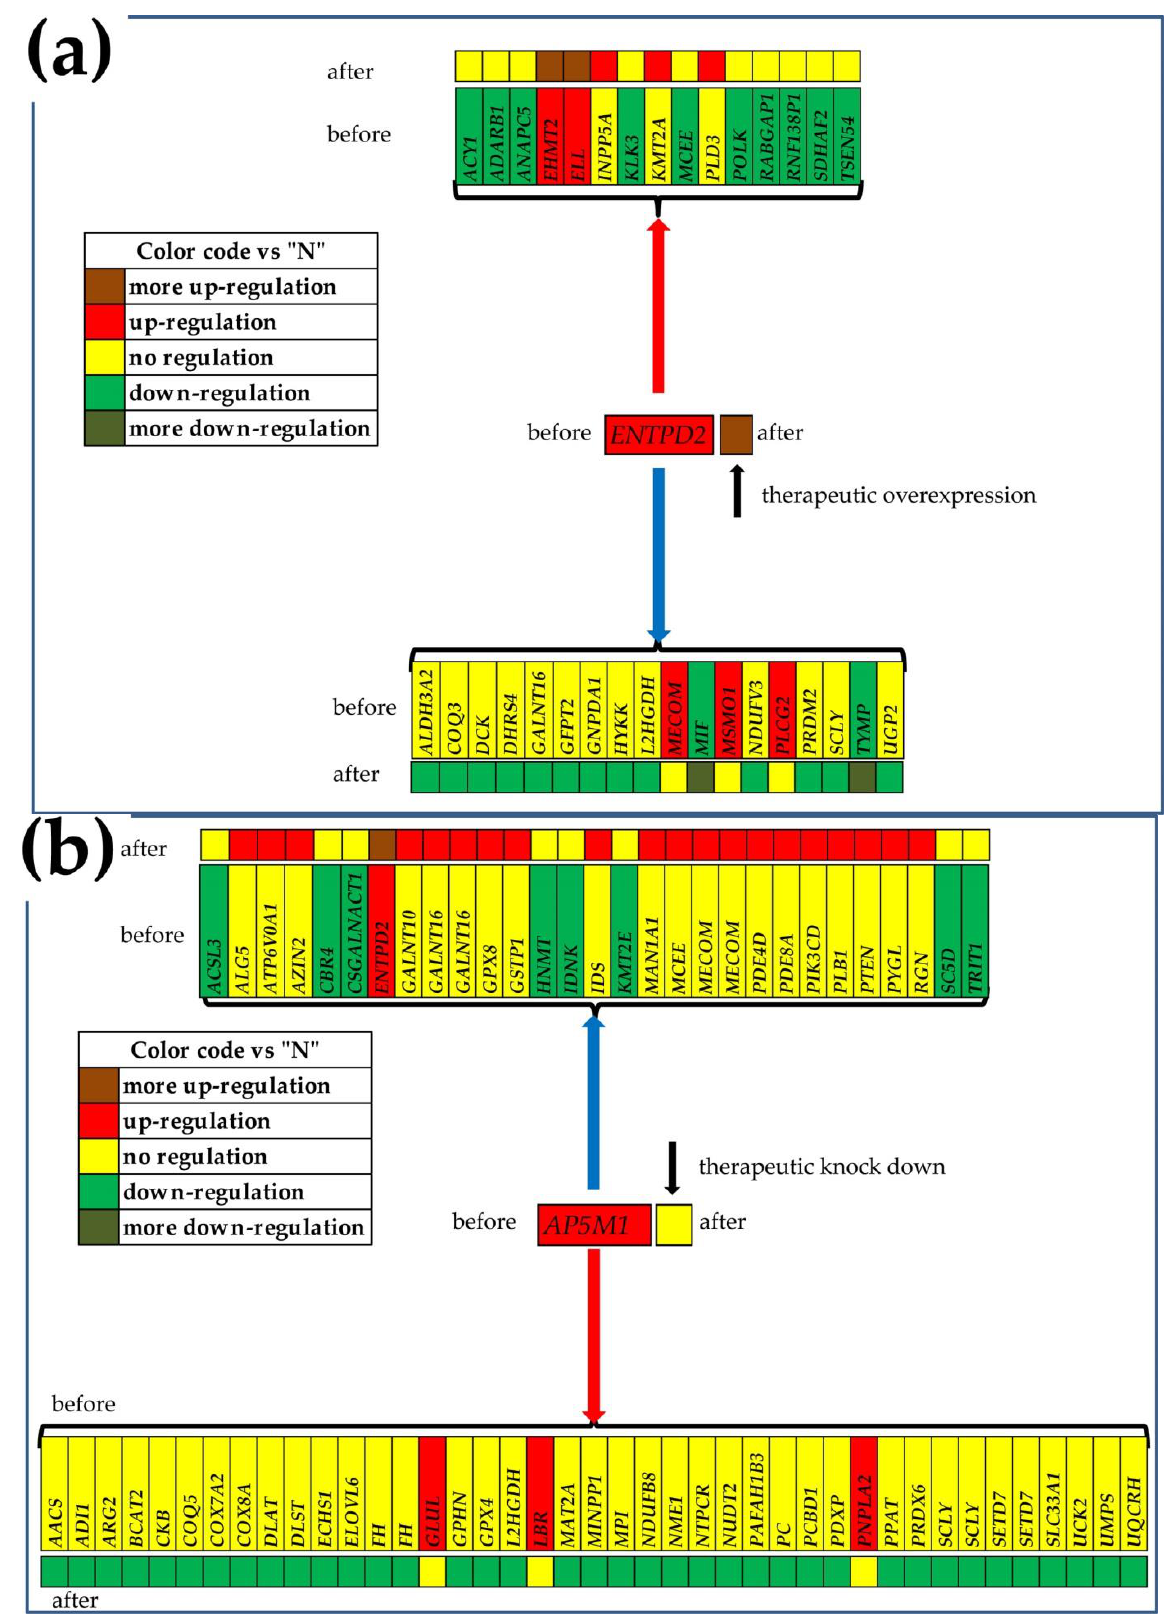
surrounding normal tissue “Z” before (observed) and after the treatment (predicted). Note the dif- ferent regulations of the metabolic genes in the cancer nodules.